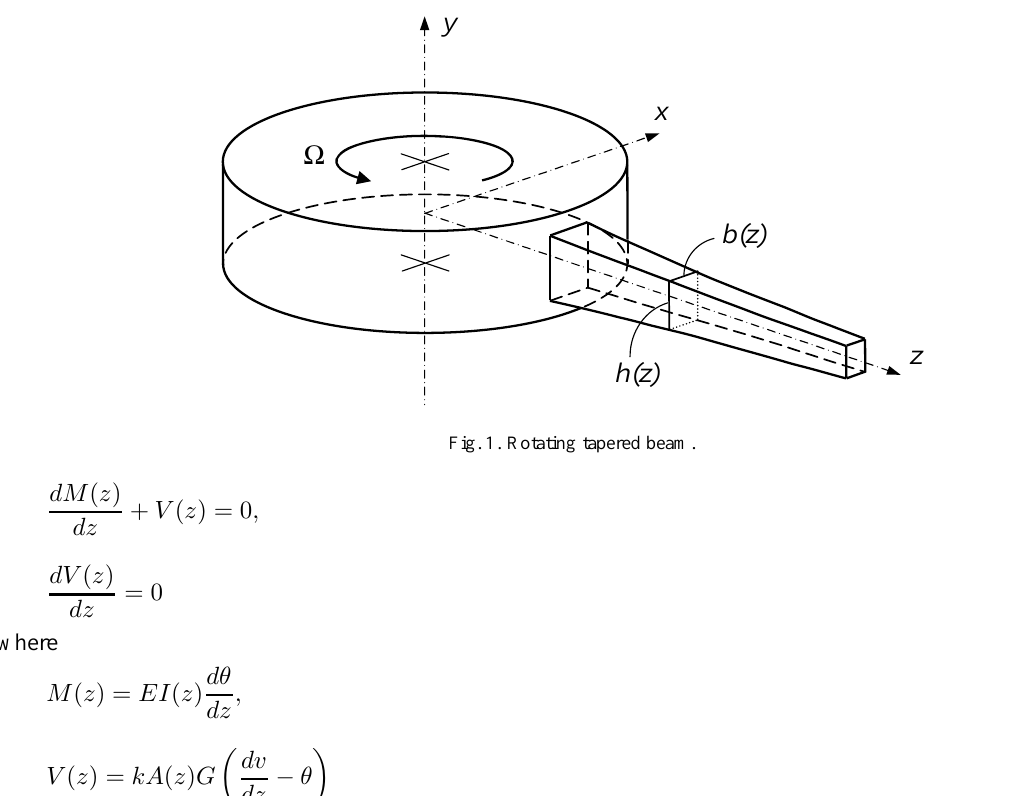
Fig. 1. Rotating tapered